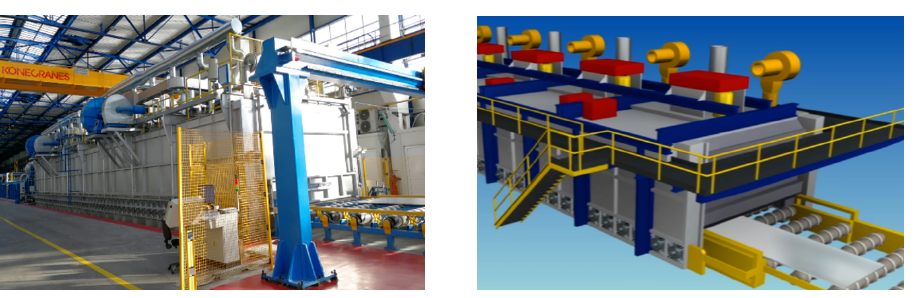
Figure 2. The independent equipment for the re- search of aluminium alloy quenching process.